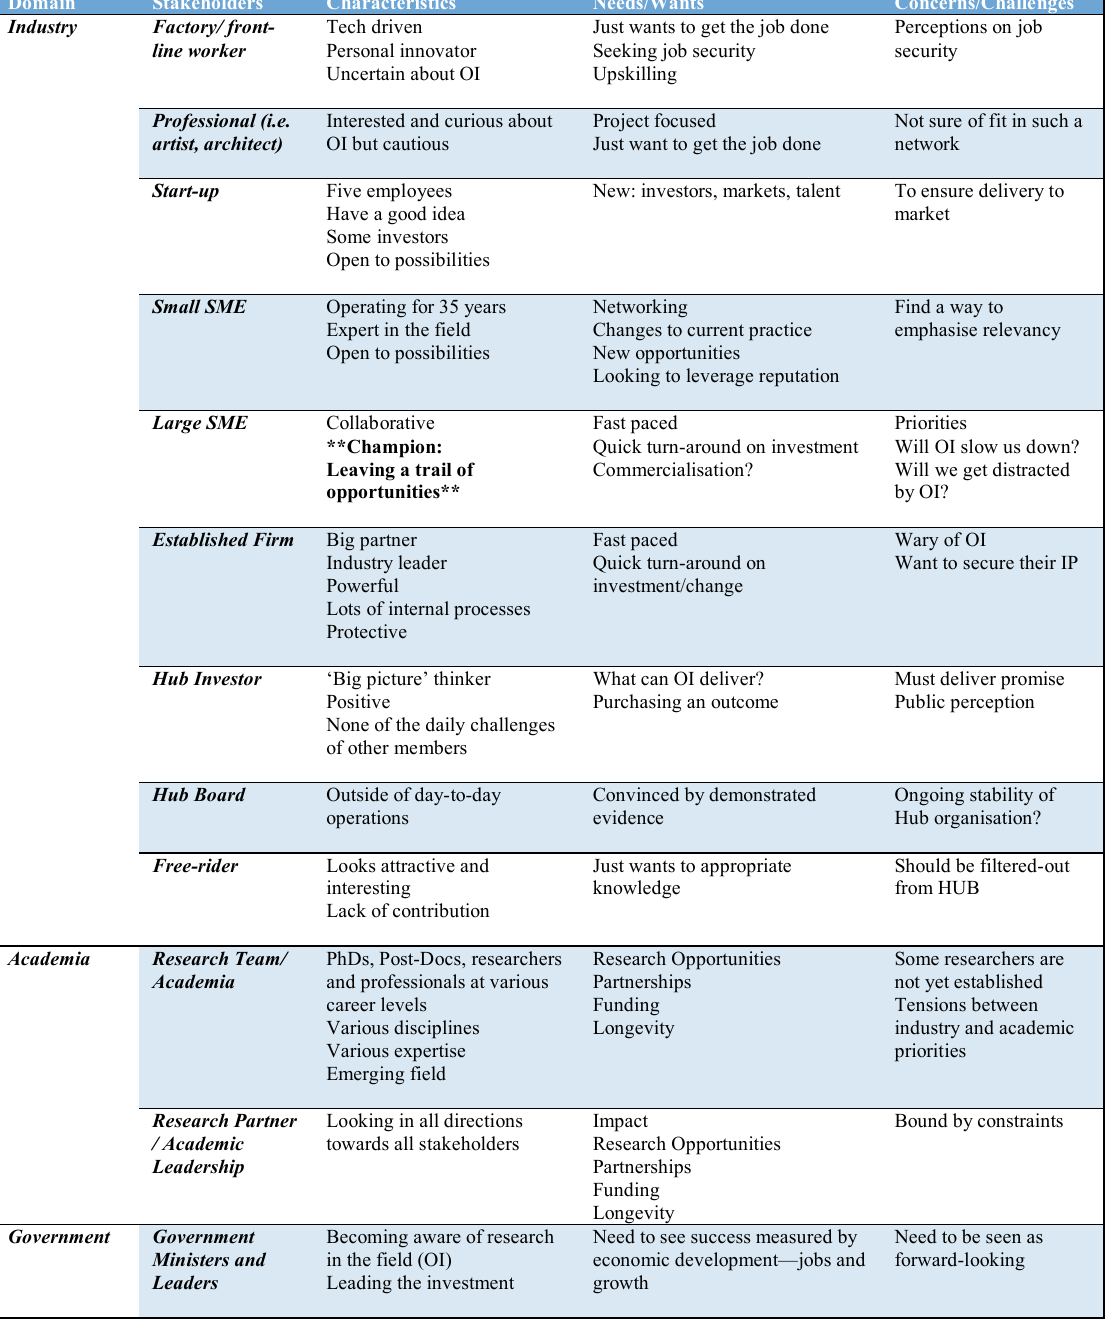
Table 1 . ARM Hub ecosystem stakeholder